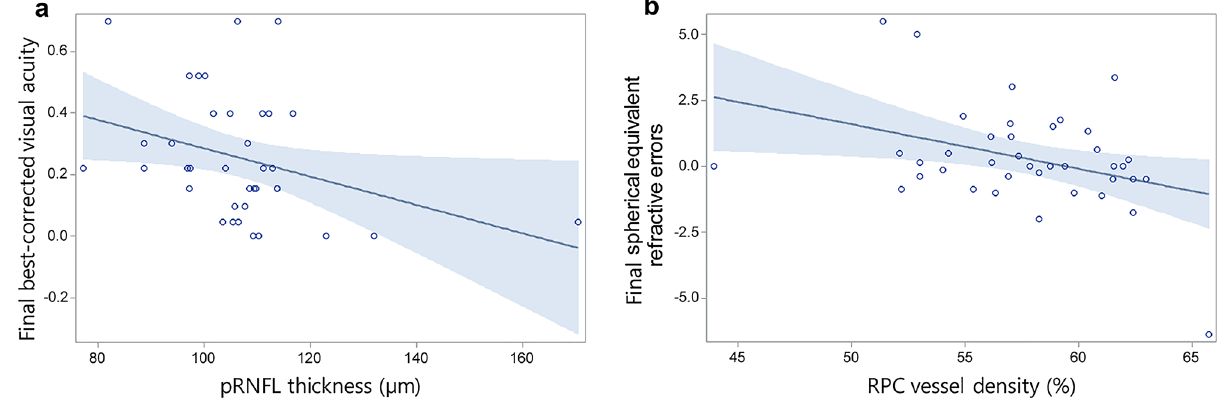
Figure 1. A scatterplot showing associations of visual function outcomes with vascular and structural parameters in retinopathy of prematurity patients. ( a ) Negative association of the peripapillary retinal nerve fiber layer (pRNFL) thickness with final best-corrected visual acuity ( Beta = − 0.005, p = 0.0437) in retinopathy of prematurity (ROP) patients with laser treatment. ( b ) Negative association between radial peripapillary capillary (RPC) vessel density and final spherical equivalent refractive errors ( Beta = -0.171, p = 0.0258) in spontaneously regressed ROP patients. Black line indicates linear regression line. Dark gray area indicates 95% confidence